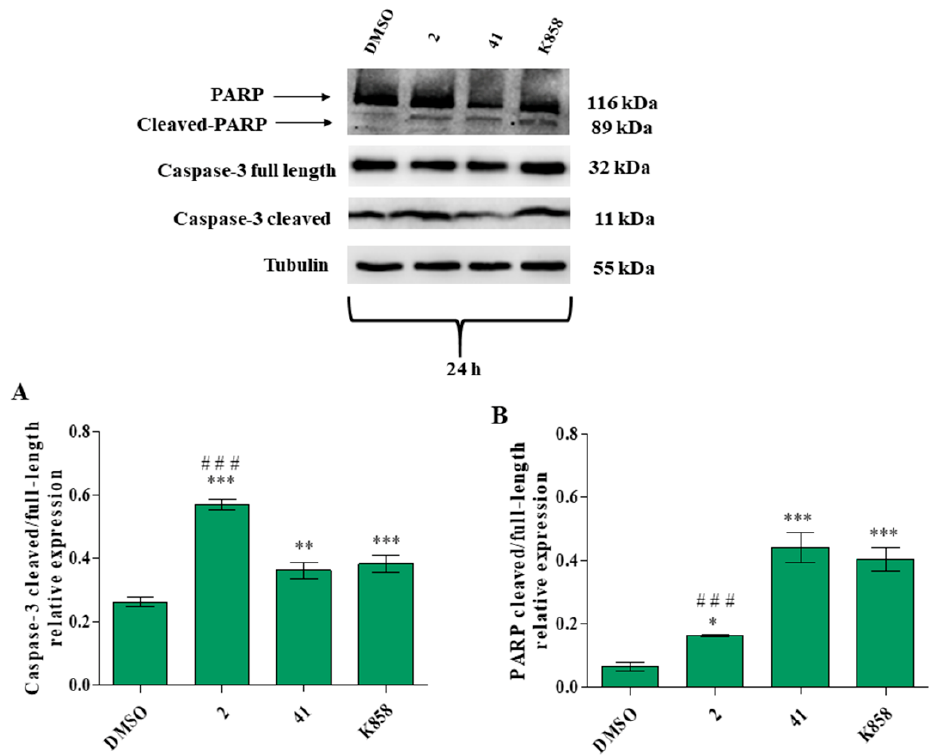
Figure 13. Caspase-3 and poly(ADP-ribose) polymerase (PARP) protein expression levels in MCF7 cell line treated with 2 (1.5 μ M), 41 (5 μ M) and K858 (10 μ M) for 24 h. DMSO: control vehicle. Data